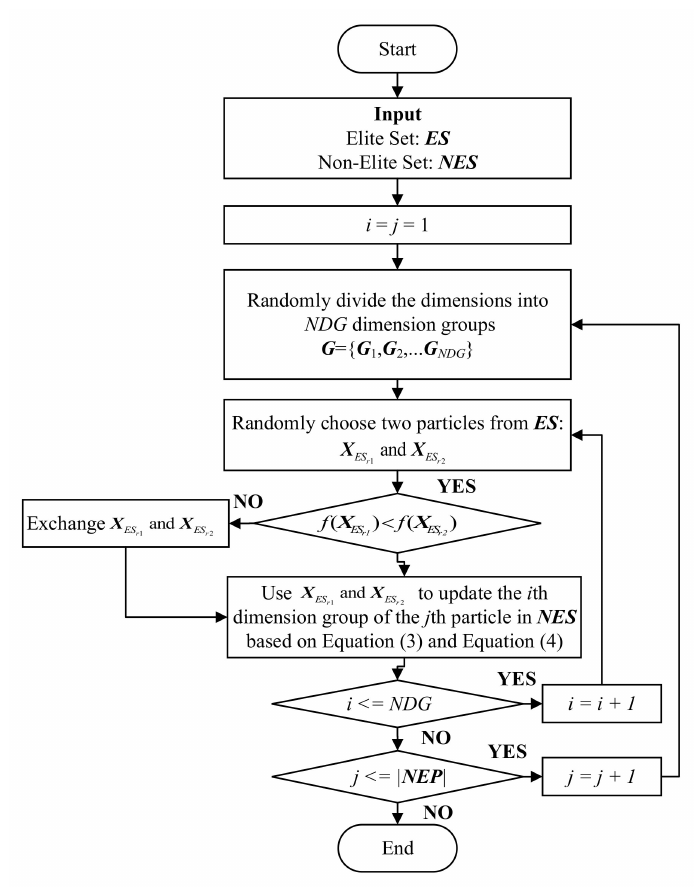
Figure 1. Flowchart of the proposed DGCEL